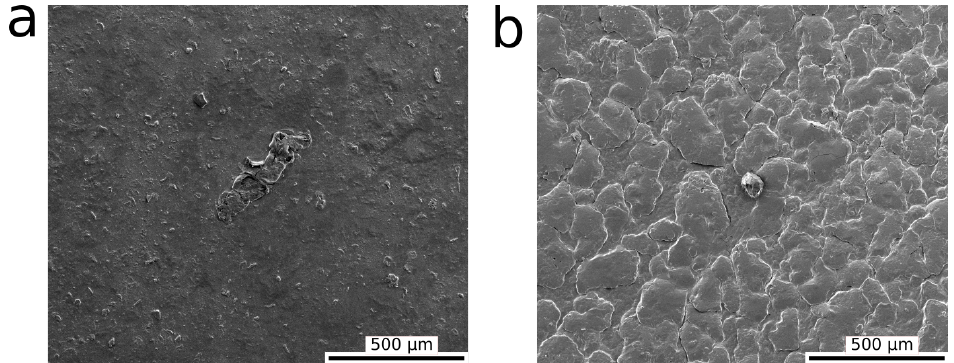
Figure 3. SEM images showing the surface morphology of hydrogels: ( a ) PAA, and ( b ) PAH3 (14 wt% HBP3), at a spatial resolution of 500 µ